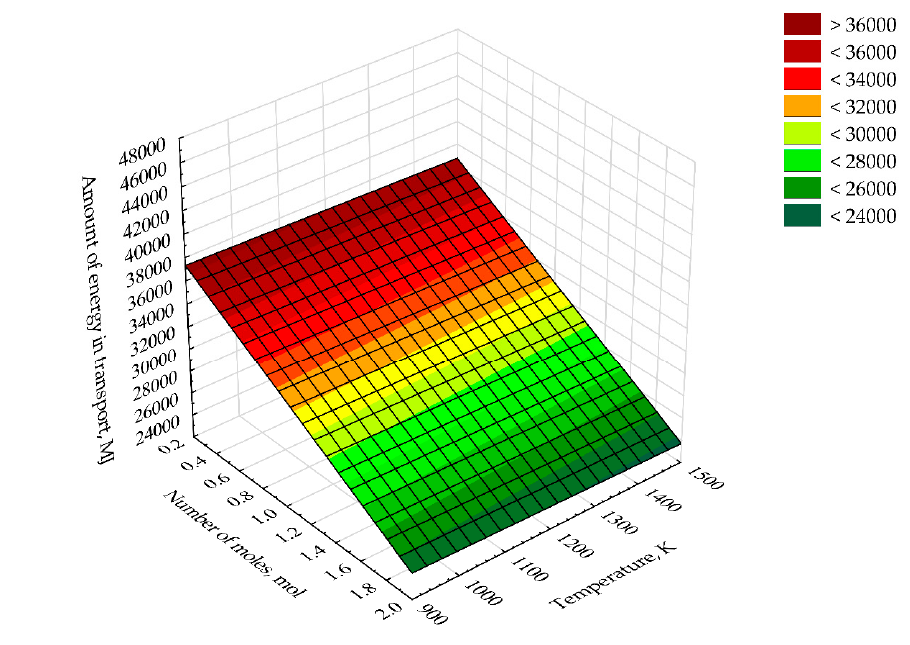
Figure 12. Energy content in the transport of syngas in the pressure vessels with a capacity of 14.960 m 3 at 200 bar at 293 K as a function of the number of moles of the gasification agent (x) and the temperature (y) of the gasification process using H 2 O.